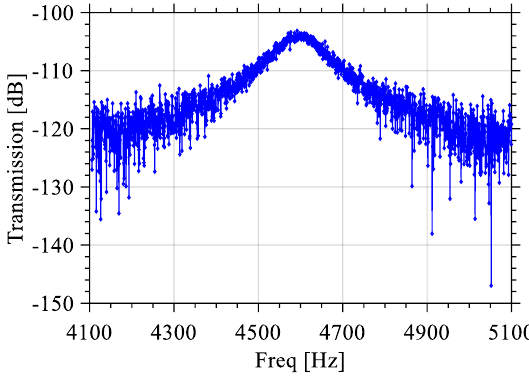
Figure 14. Measured frequency response of Design